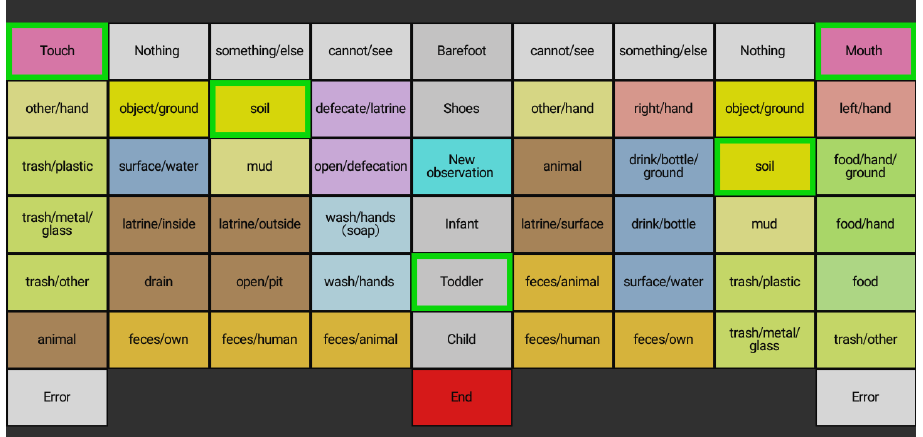
Figure 2. Customized LiveTrak™ application for public observations in Corail, Haiti (illustrated in English; a Kreyol version was used in the field). As depicted by the selected objects, the palette indicates that an observed toddler is touching soil and engaging in